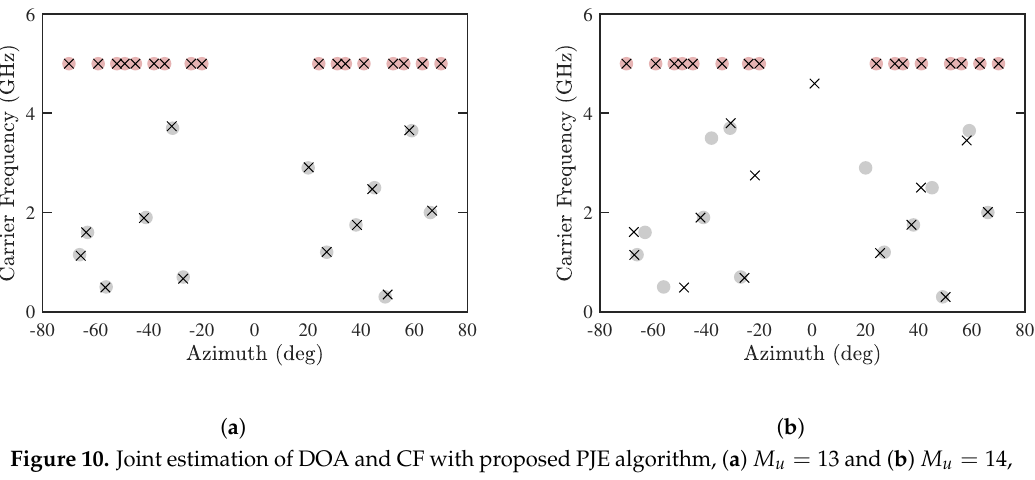
Figure 9. Normalized SS-MUSIC spectrum with Algorithm 1, ( a ) M u = 13 and ( b ) M u = 14, SNR = 10 dB, Q = 300, M = 30. ———: actual DOA of CF-known sources, ———: actual DOA of CF-unknown sources, − − − : estimated DOA with x -axis CPA, − − − : estimated DOA with z -axis CPA, × : matched DOA.